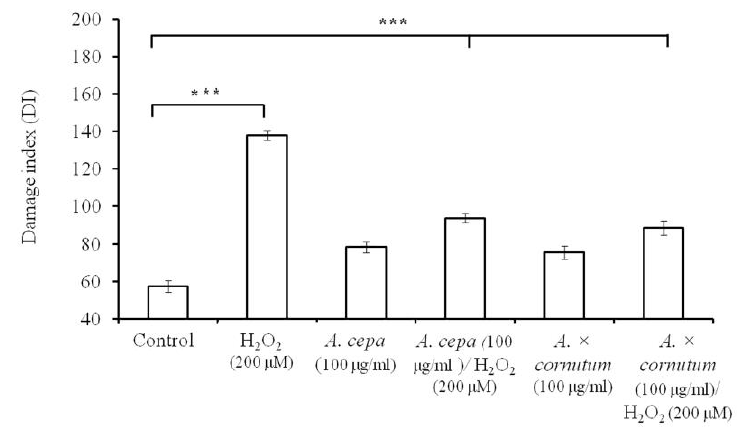
Figure 3. DNA damage index (DI) of treated human leukocytes: control, H 2 O 2 (200 µ M), A. cepa (100 µ g/mL), A. cepa with H 2 O 2 , A. × cornutum (100 µ g/mL), and A. × cornutum with H 2 O 2 ; *** p < 0.001.